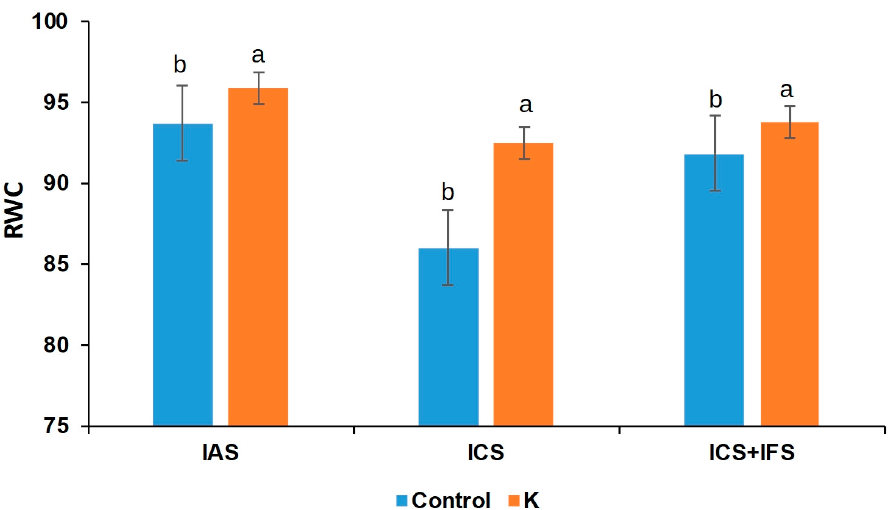
Figure 6. Interaction e ff ect of foliar application of K and irrigation levels on GY and profitability parameters of wheat. Means having di ff erent letter are significantly di ff erent from each other at